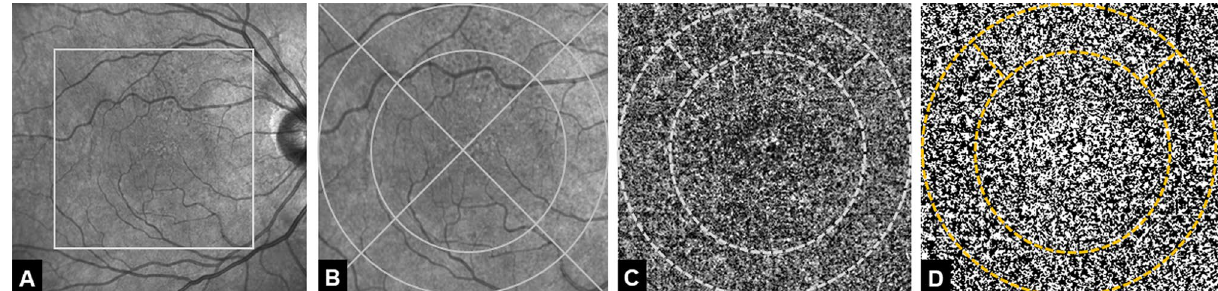
Figure 1. Representative patient with reticular pseudodrusen (RPD) at baseline. ( A ) Near-infrared confocal scanning laser opththalmoscopy (cSLO) image showing hyporeflective dots located superiorly to the fovea. Rectangle marks the area of 6 × 6 mm magnified in ( B ) Overlaid grid with two circles of 4 mm and 6 mm diameter as well as two lines dividing the area in four quadrants. ( C ) 6 × 6 mm optical coherence